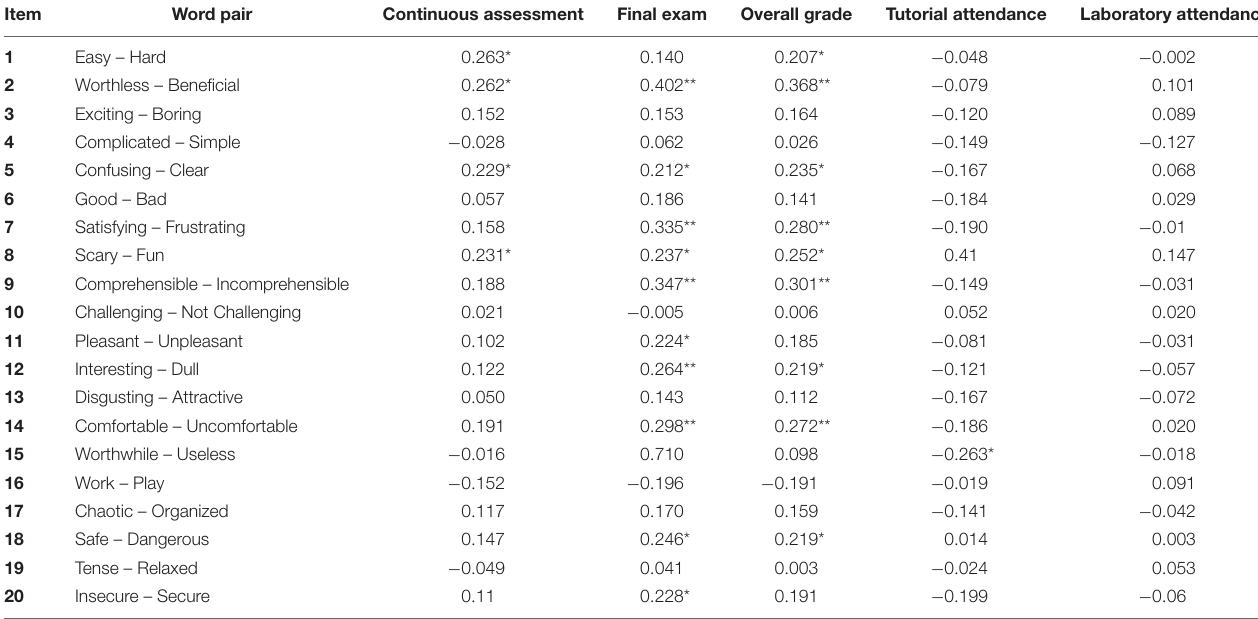
TABLE 4 | Pearson correlation coefficients (r) between individual items on the ASCI and student achievement and attendance rates ( n = 95 students). Item Word